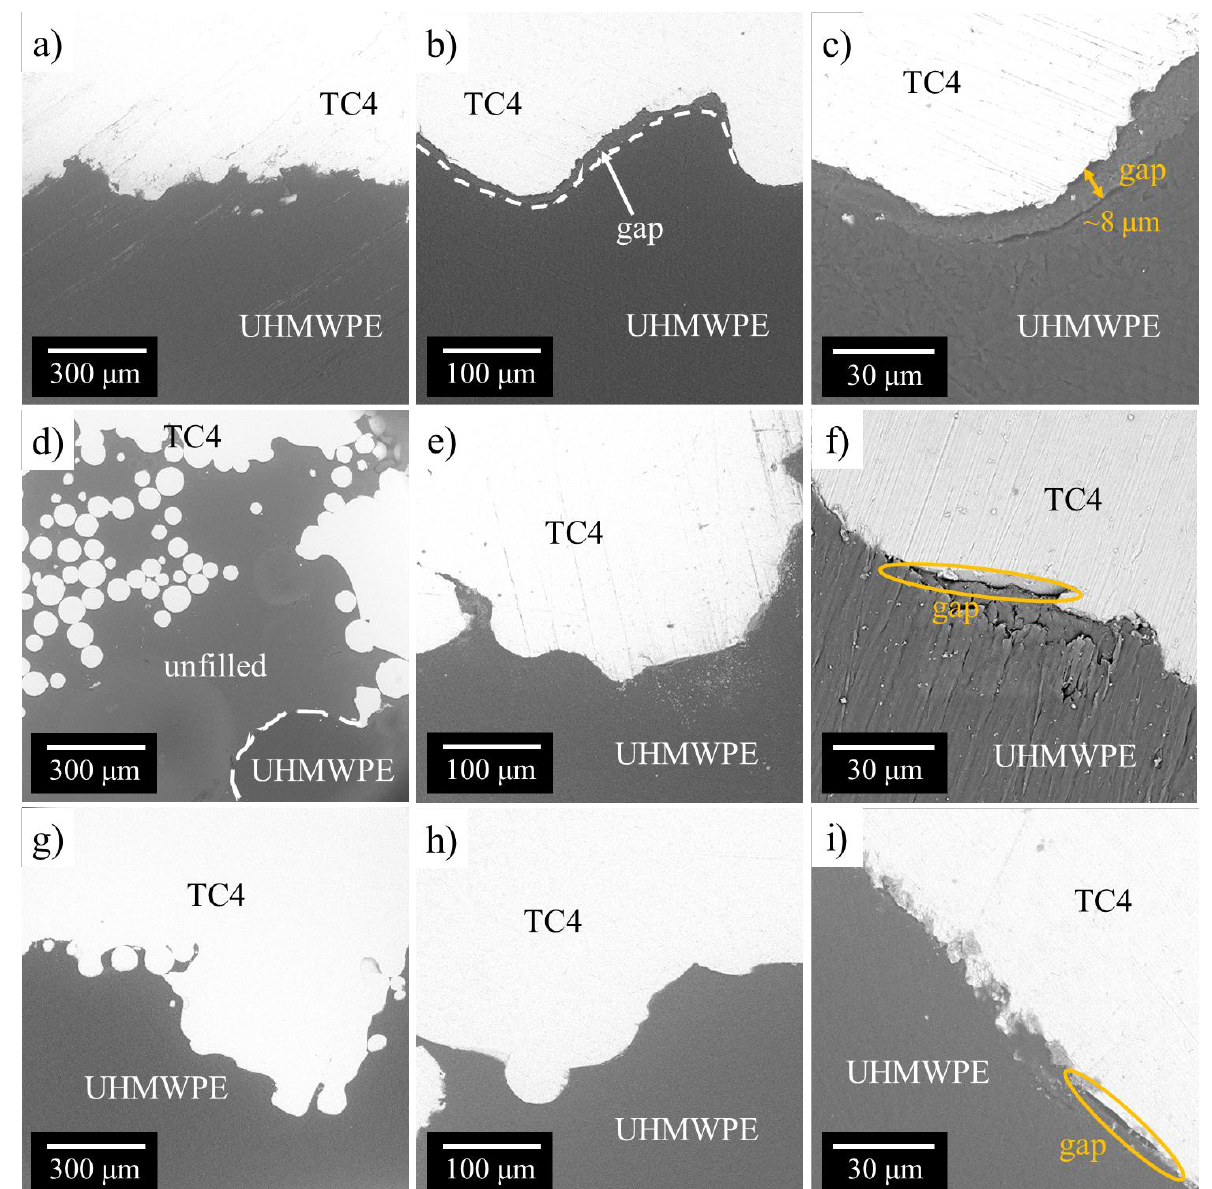
Figure 6. Microscale interfaces of TC4–UHMWPE joints with different surface structures: ( a – c ) non-structured (NS); ( d – f ) diamond-shaped (DS); ( g – i ) honeycomb (HC).